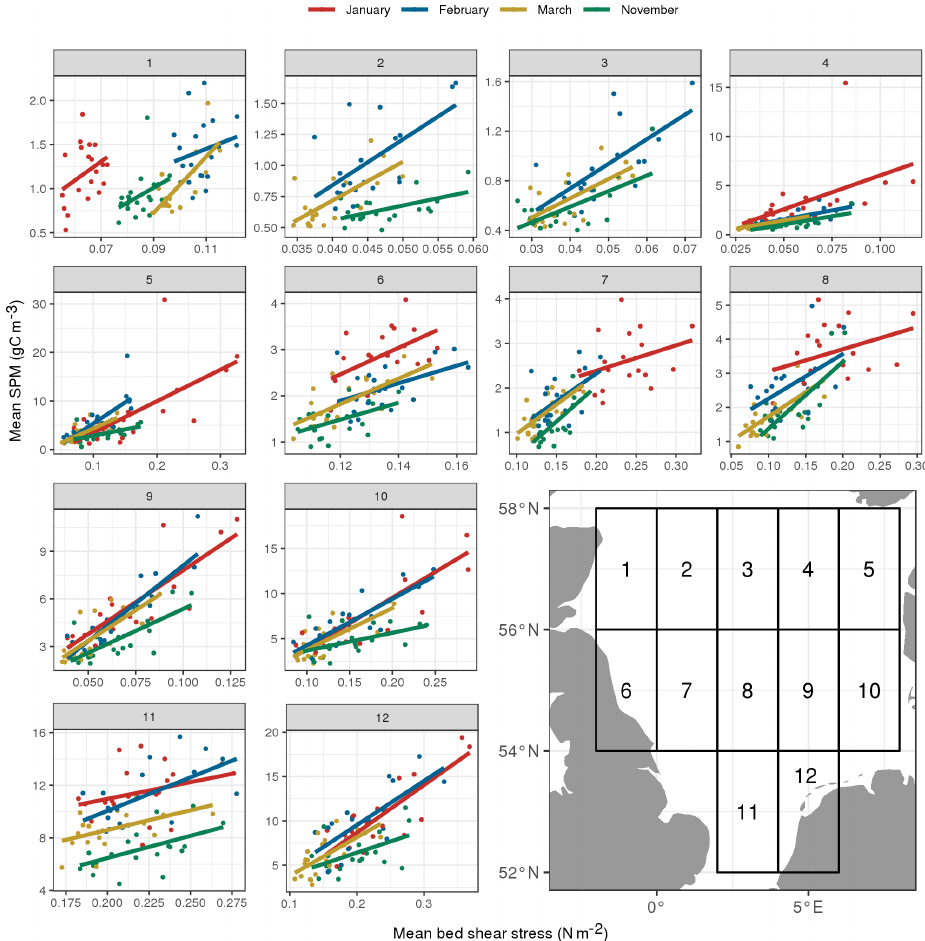
Figure 5. Monthly regressions of mean SPM and bed shear stress for binned regions in the North Sea. The coloured lines represent regressions for the months January, February, March and November. For each mapped box and month, grid points with a 20-year record of SPM are selected. The regression of monthly SPM and bed shear stress is then derived by averaging the selected values in each. Months shown are those when the water column is permanently mixed, with December ignored due to poor data coverage. Statistical parameters for the regressions are shown in Table